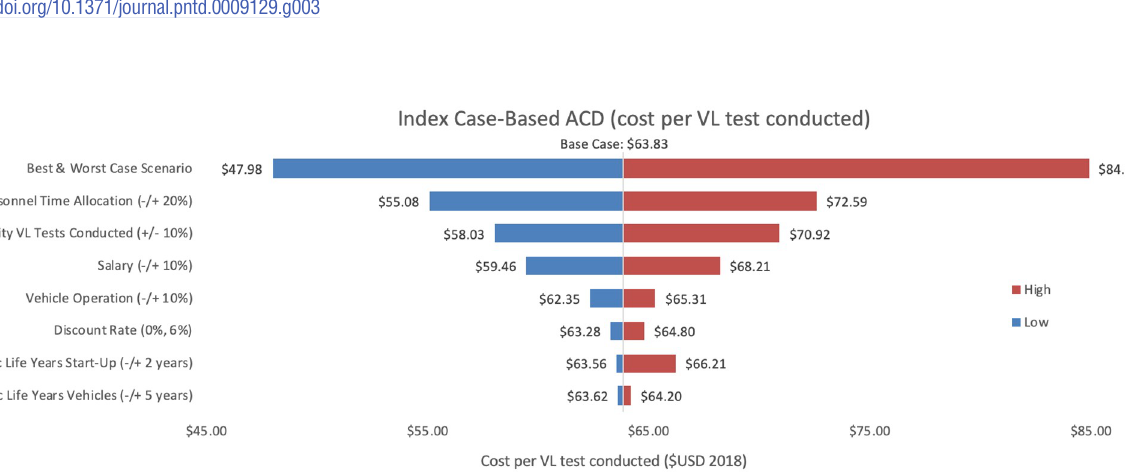
Fig 3. Sensitivity analysis of blanket & camp ACD per VL test conducted. Variations in blanket & camp ACD cost per VL test conducted in Bihar during 2018.